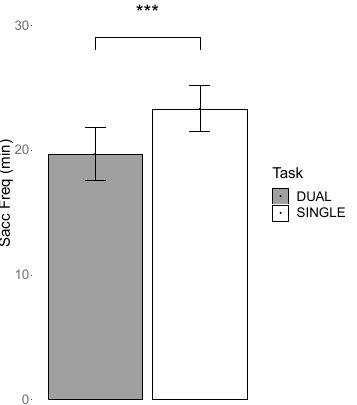
Figure 8. Mean saccade frequency as a function of task difficulty. *** p < 0.001.